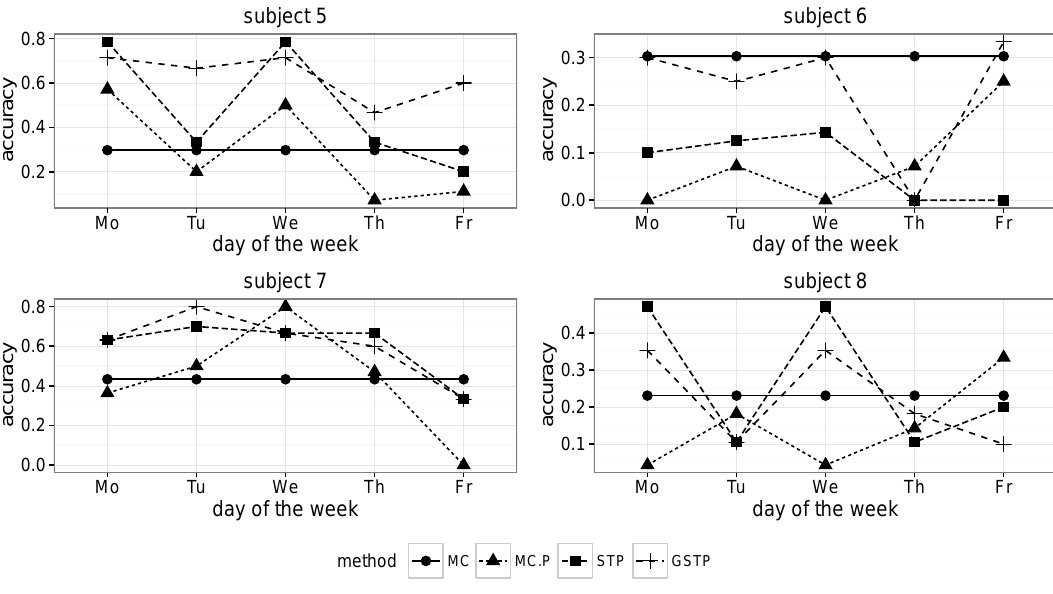
Figure 7. Accuracy results across the days of the week for Subjects 5 to